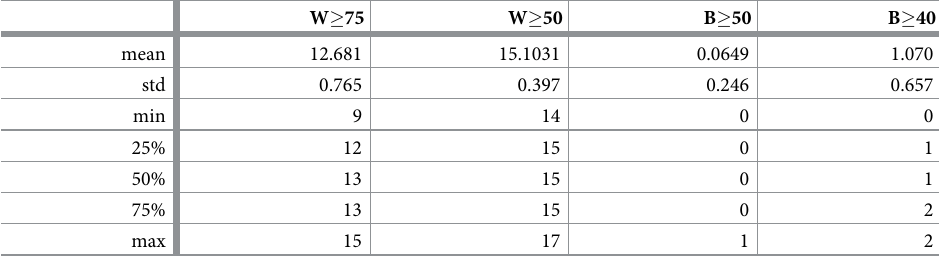
Table 7. Statistical summary of white and Black proportions in discovered districting plans.